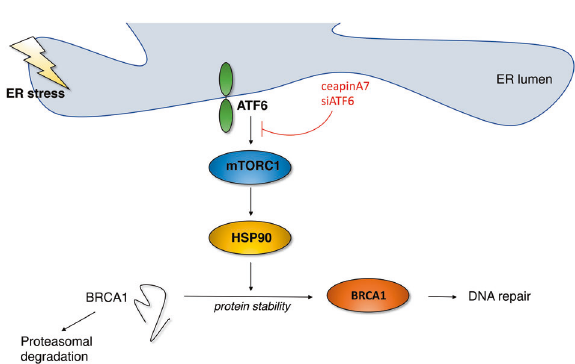
Fig. 8 Representative scheme illustrating the role of ATF6 in sustaining the mTOR/HSP90/BRCA1 axis. ATF6 pharmacological or genetic inhibition reduces BRCA-1 stability in stressed cells and promotes its proteasomal